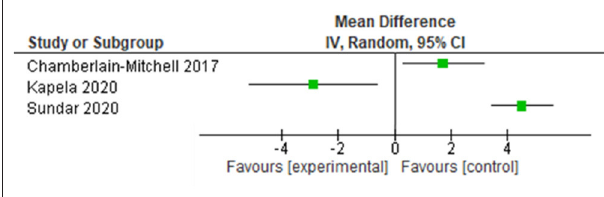
FIGURE 3 | Effects of non-pharmacological interventions on cough-related quality of life. Date of publication of records included in the